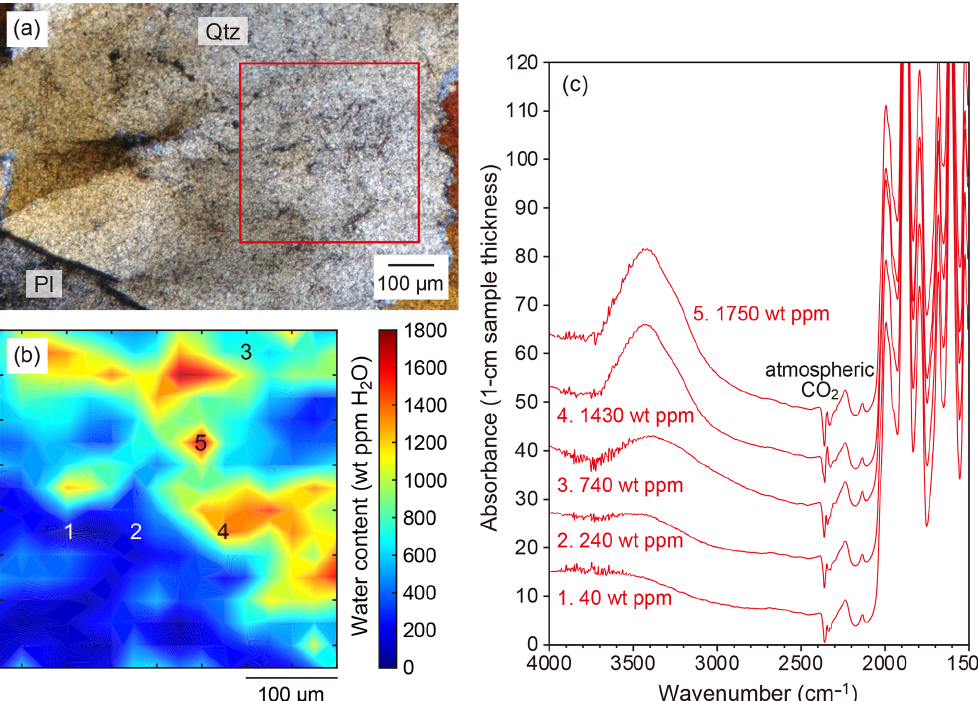
Figure 6. IR mapping results for the almost-undeformed sample. The sample thickness is 60µm. (a) Optical photomicrograph under cross- polarized light. The IR mapped area is shown with a red square. (b) Water distribution. Numbers represent raw IR spectra in (c) from low to high water